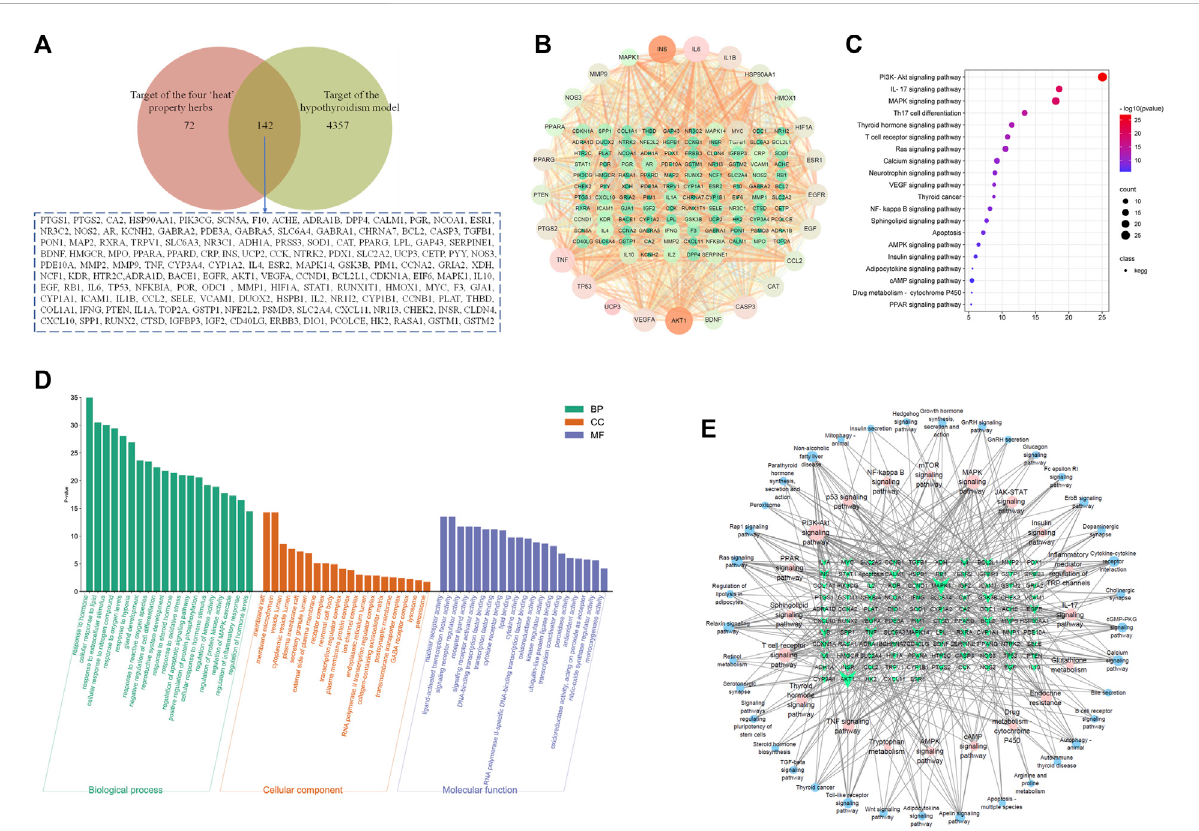
The target and network analysis of the four typical “ hot ” property herbs and the hypothyroidism model. (A) : The Venn diagram of the common targets obtained from hypothyroidism and components of the four typical “ hot ” property herbs; (B) : The PPI network with high-frequency node analysis by 142 common targets; (C) : The common target pathway enrichment analysis; (D) : the GO analysis of the biological processes, cellular components, and molecular functions with common targets; (E) :The key targets and signaling pathway networkrelation-based GO and KEGG